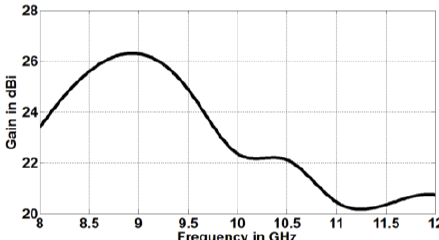
Figure 6: Calculated antenna gain for initial design using the analytical technique.